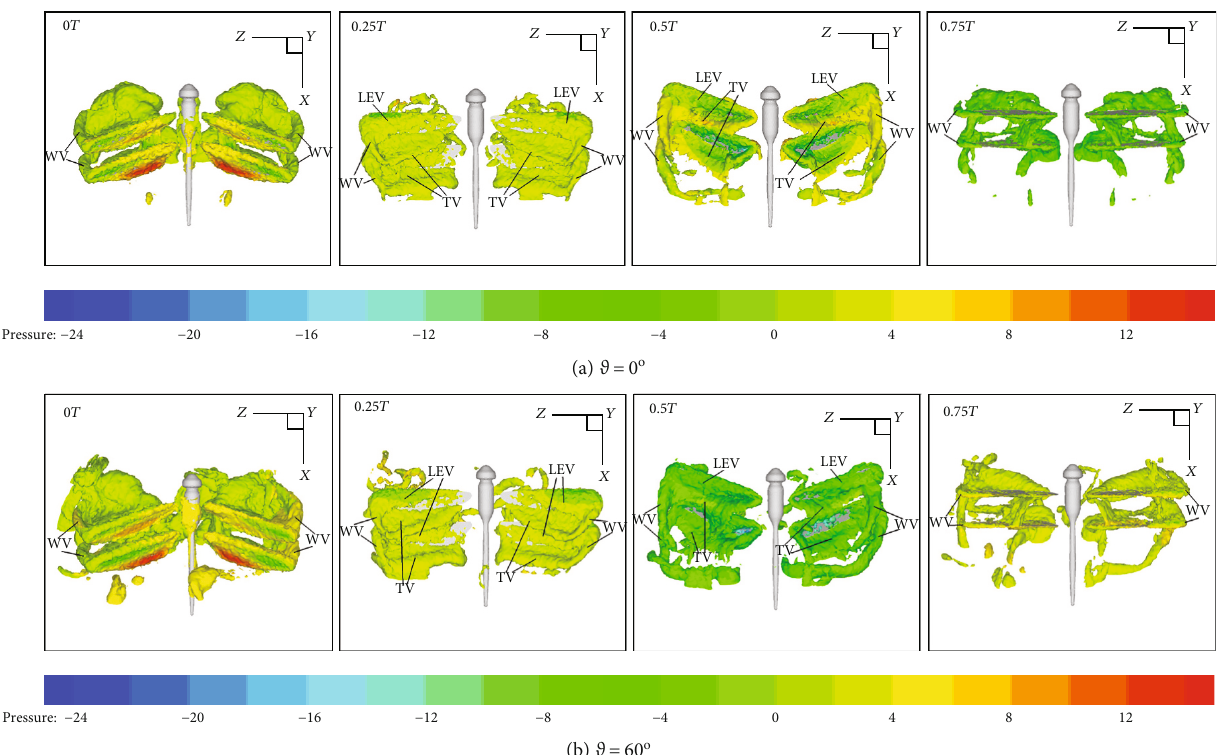
Figure 10: Isovorticity surface plots at various times in one